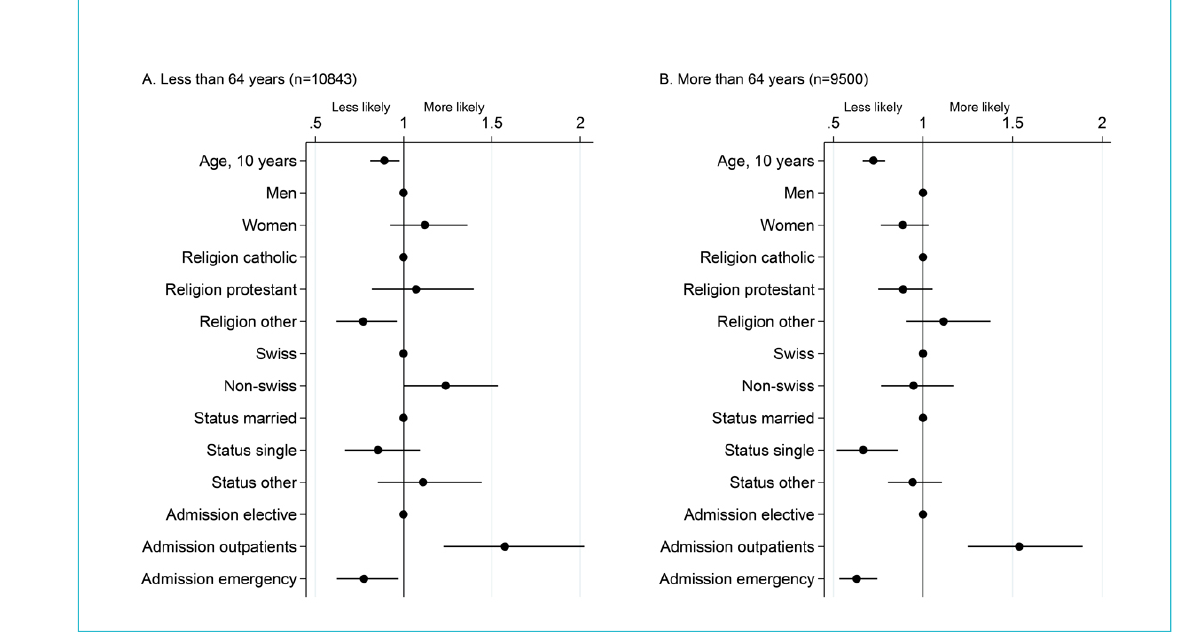
Figure 3: Factors associated with willingness to receive incidental findings among the 20 343 participants . Dots represent odds ratios and bars 95% confidence intervals from a multivariable logistic model including willingness to receive incidental findings, among patients hav- ing accepted to participate, as the dependent variable, run separately in the two age